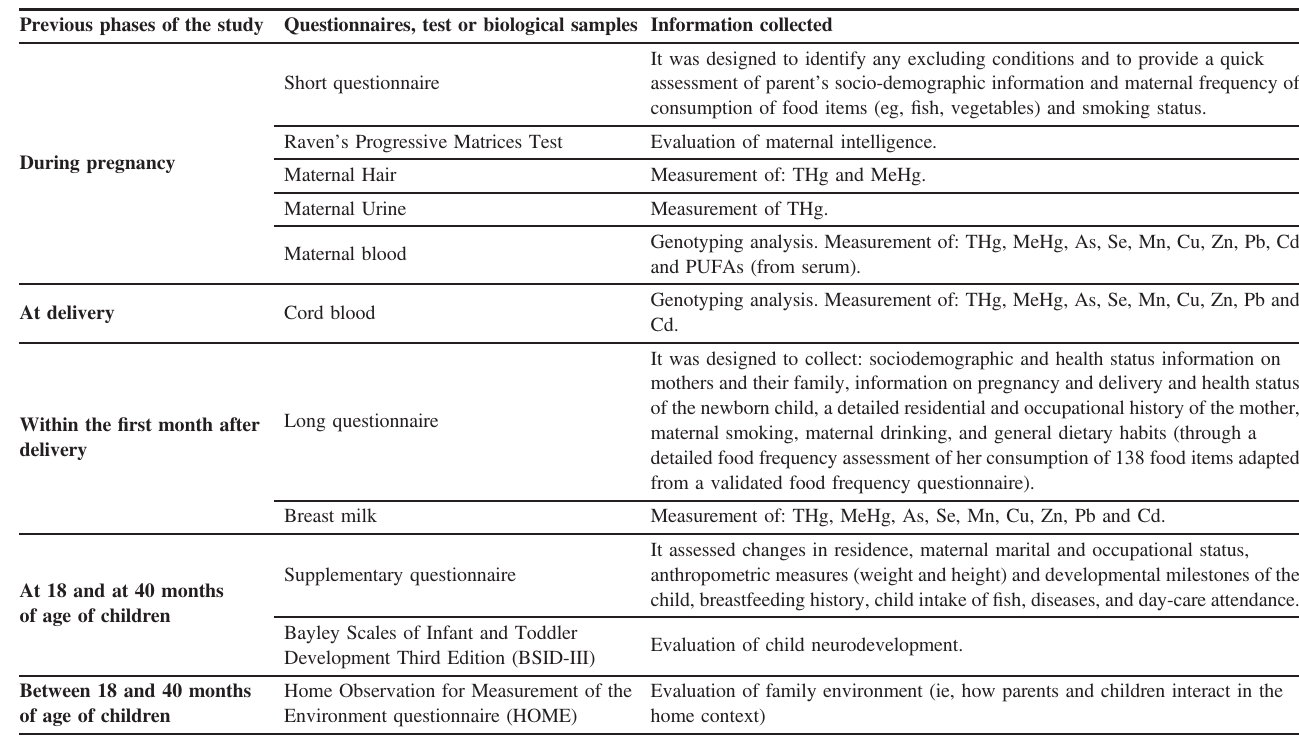
Table 2. Questionnaires, test and biological samples collected before the 7 years old of children Previous phases of the study Questionnaires, test or biological samples Information collected